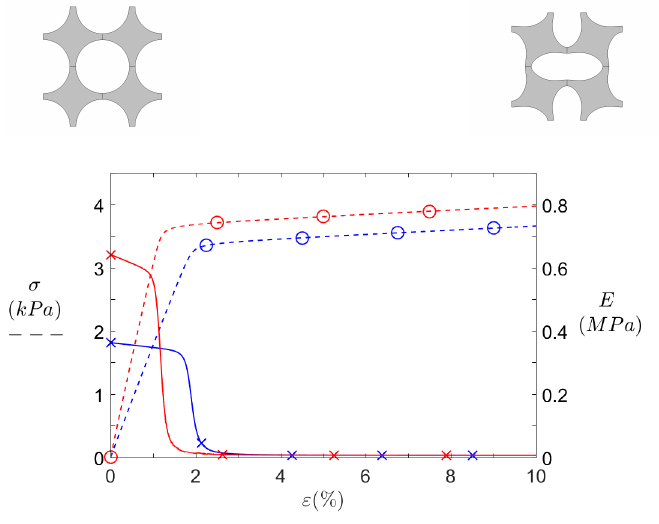
Figure 10. Static behaviour of S 0 (blue) and S R (red) patterns under axial compression. Effective stress σ and effective Young’s modulus E against compression axis ( Y